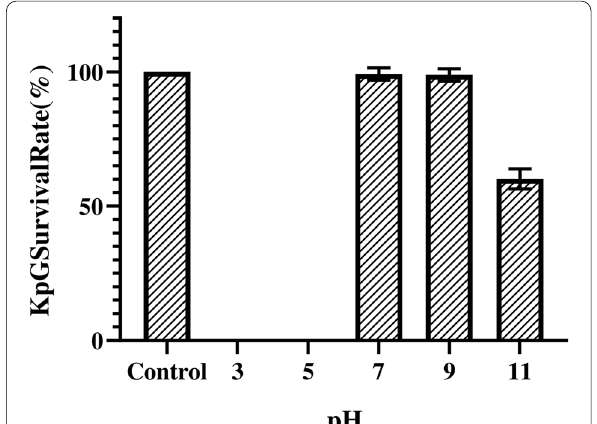
Fig.2 Stability of KpG at different pH. 10 7 PFU/ml of purified phage lysate was incubated in buffers of varying pH 3.0, 5.0, 7.0, 9.0 and 11.0 for 1 h. Phage titer was estimated using agar overlay method and survival percentage was calculated using phage titers measured in SM buffer (pH 6.8) as control. The experiment was performed in triplicates two PCRs for identification of Podoviridae by analyzing the conserved regions of their genomes. We obtained 295 bp and 97 bp amplicons for CL1 and CL2 respec- tively (Additional file 1: Fig. S5). The PCR amplicons were sequenced by Sanger sequencing and have been submit- ted in Genbank (Accession numbers: CL1-MW026685